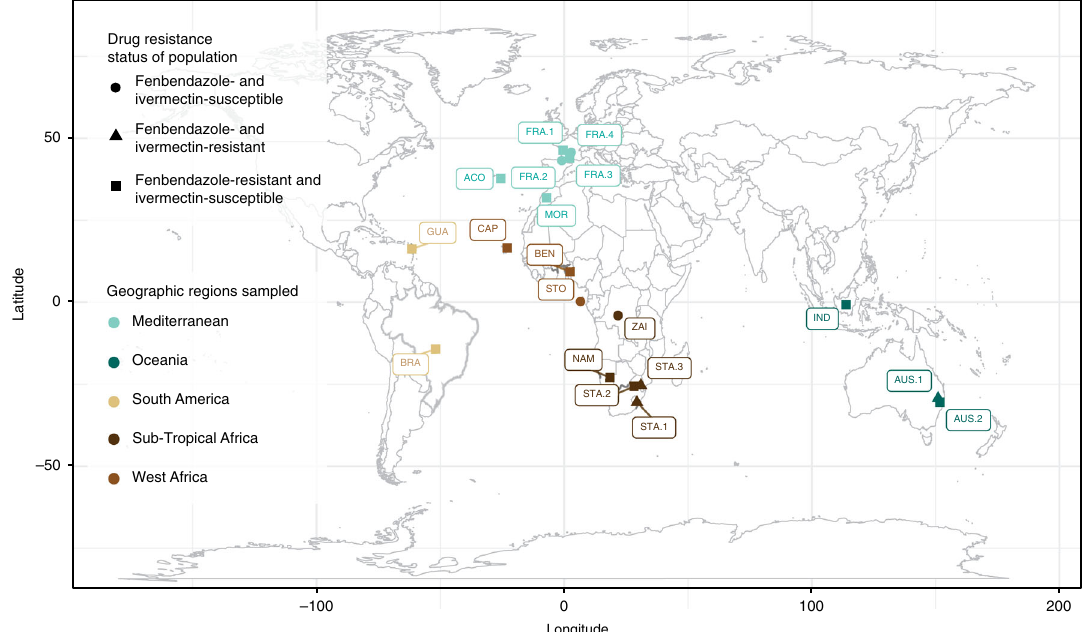
Fig. 1 Global distribution of Haemonchus contortus isolates. Isolates sampled are coloured by geographical region (sand: South-America, brown: Western- Africa, light green: Mediterranean area, dark brown: Subtropical Africa, dark green: Australia). Shape indicates the anthelmintic resistance status of each isolate (susceptible = circles; resistant to fenbendazole = squares; resistant to both ivermectin and fenbendazole = triangles)